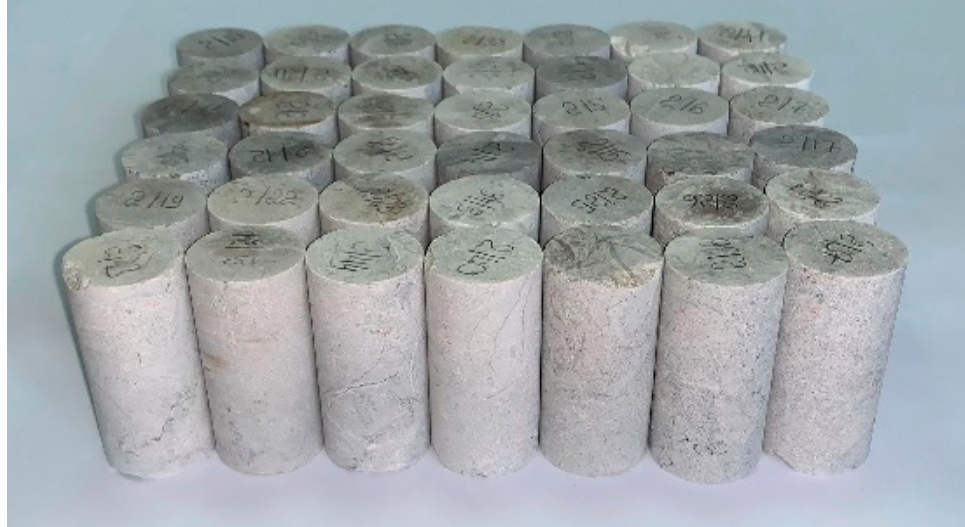
Figure 4. Prepared cylindrical samples of carbonate rock.